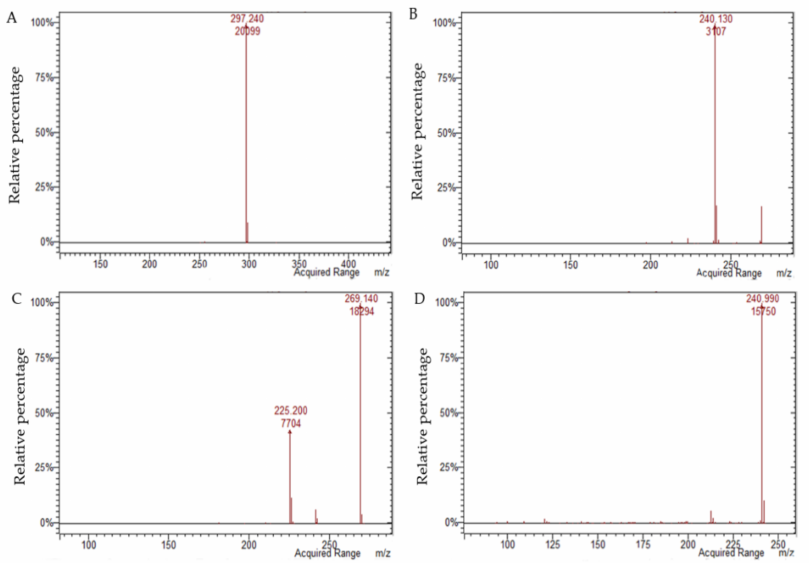
Figure 4. Fragmentation spectra of HAD reference standards obtained from the chromatogram in the MS/MS scan: aloin A or aloin B ( A ), aloe emodin ( B ), emodin ( C ), and danthron ( D